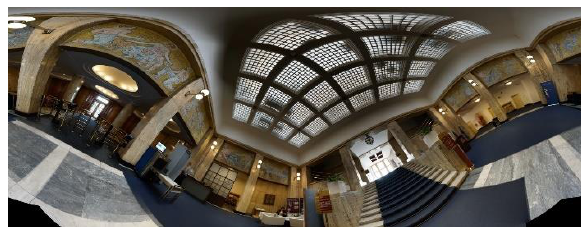
Figure 8. 360 VR panorama in MISYS SPRÁVA BUDOV.